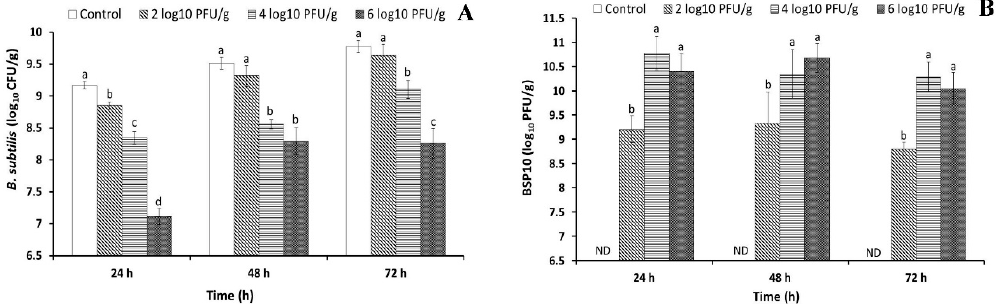
Figure 6. Changes of B. subtilis ATCC 15245 counts in the presence of bacteriophage BSP10 ( A ) and propagation of bacteriophage BSP10 during Cheonggukjang fermentation ( B ). Cheonggukjang was